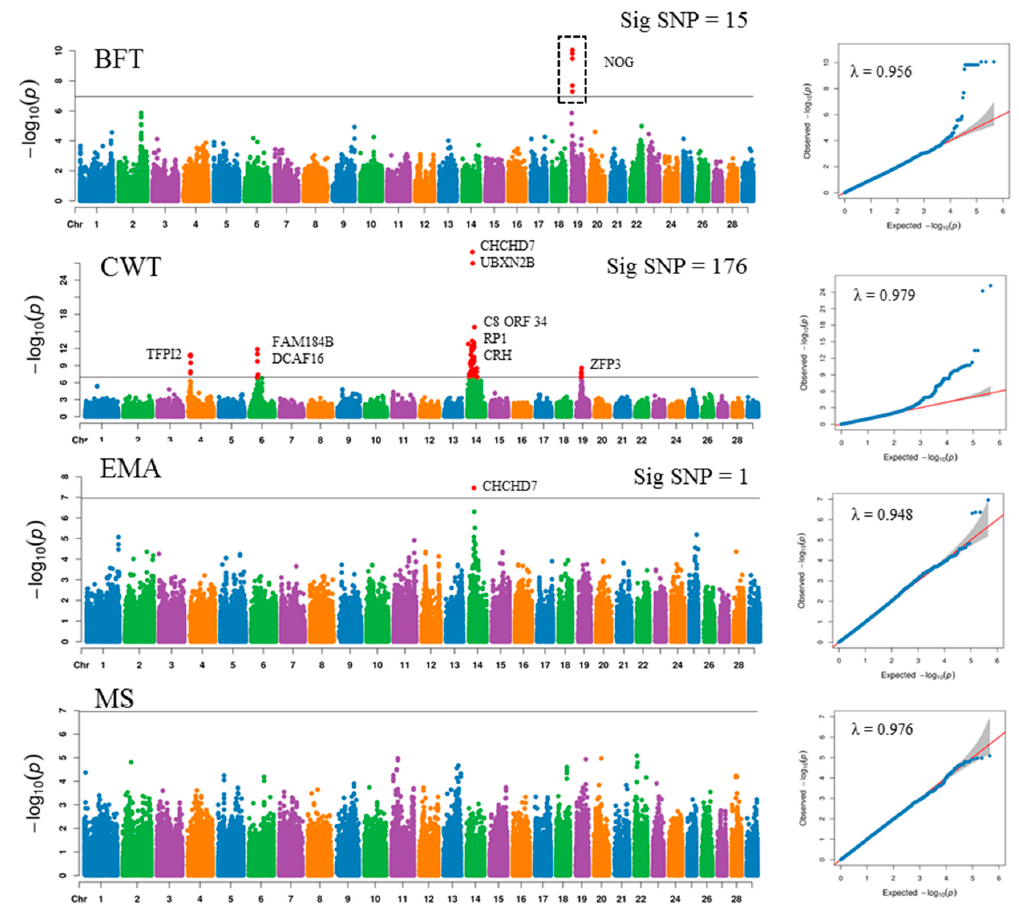
Figure 2. Manhattan plots of mapped single nucleotide polymorphism (SNP) markers associating with each trait, where the Y -axis defines the –log10 ( p )-value against their respective positions on each chromosome ( X- axis).